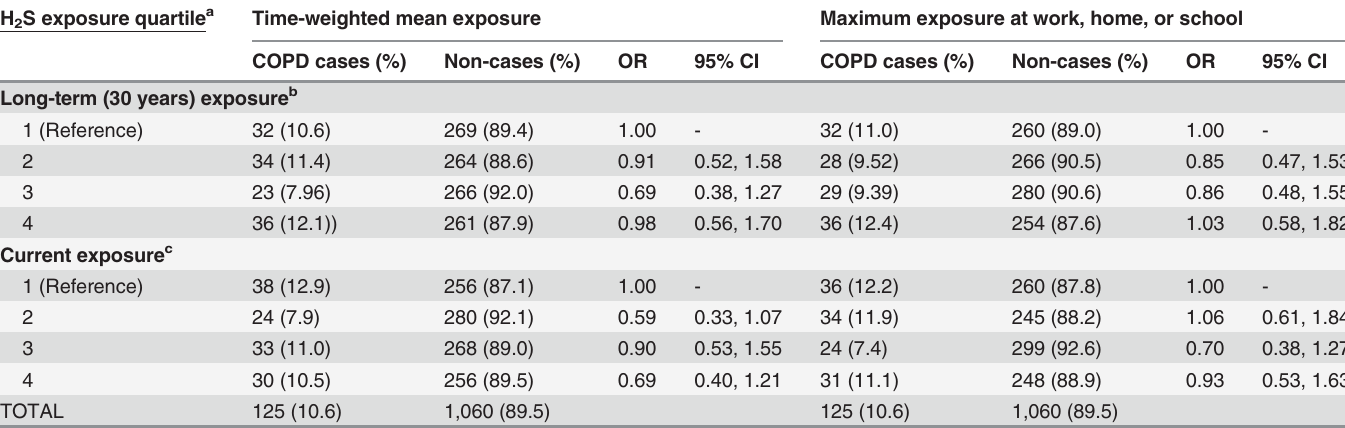
Table 5. Unconditional logistic regression analysis of COPD and both long-term (up to 30-years) and current H 2 S exposure metrics in Rotorua city residents, 2008 – 2010, limited to participants with satisfactory post-bronchodilator measurements (N = 1,185). H 2 S exposure quartile